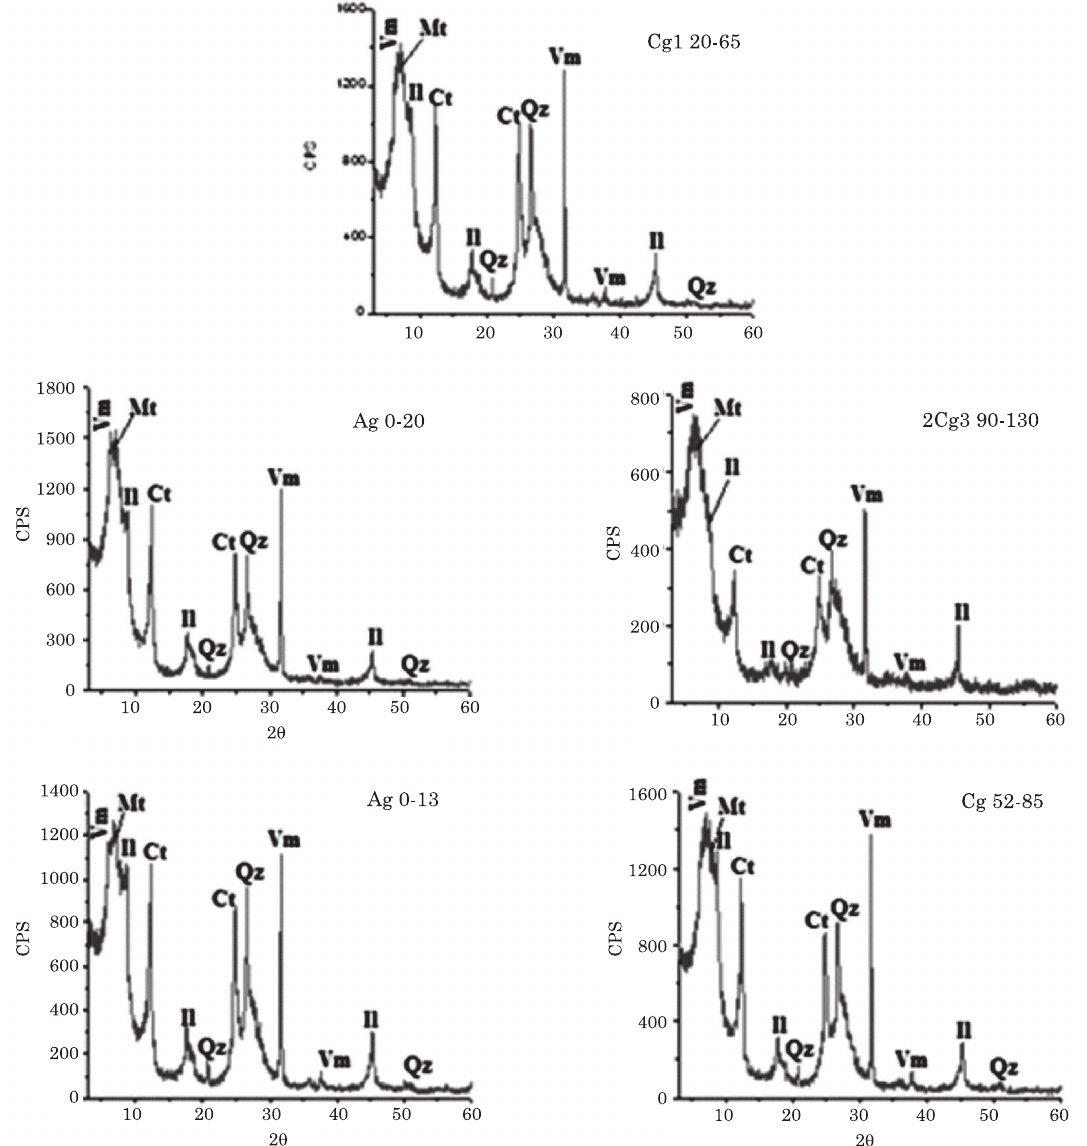
AM: CM-2: Costa do Marrecão (Ag 0-20; Cg 1 20-65; 2Cg 3 90-130); CAL-3: Caldeirão (Ag 0-13; Cg 3 52-85):